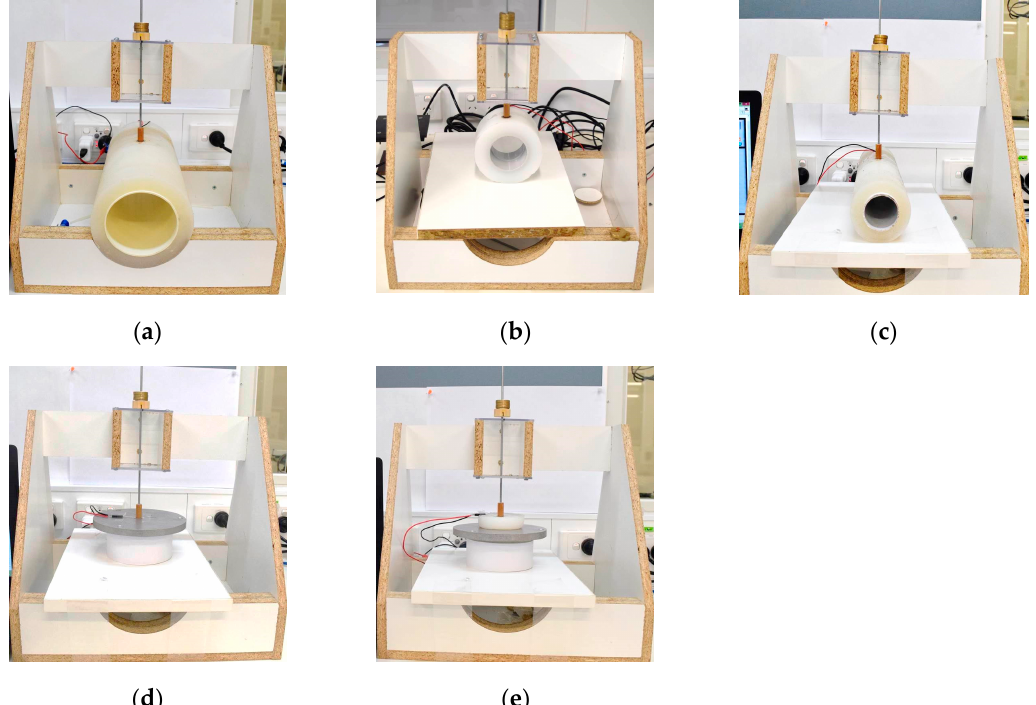
Figure 2. Experimental setup showing test surfaces: ( a ) test cylinder with 13 cm diameter; ( b ) test cylinder with 11 cm diameter; ( c ) test cylinder with 7 cm diameter; ( d ) rigid flat aluminium surface; ( e ) soft flat surface with 2 cm thick silicone layer.